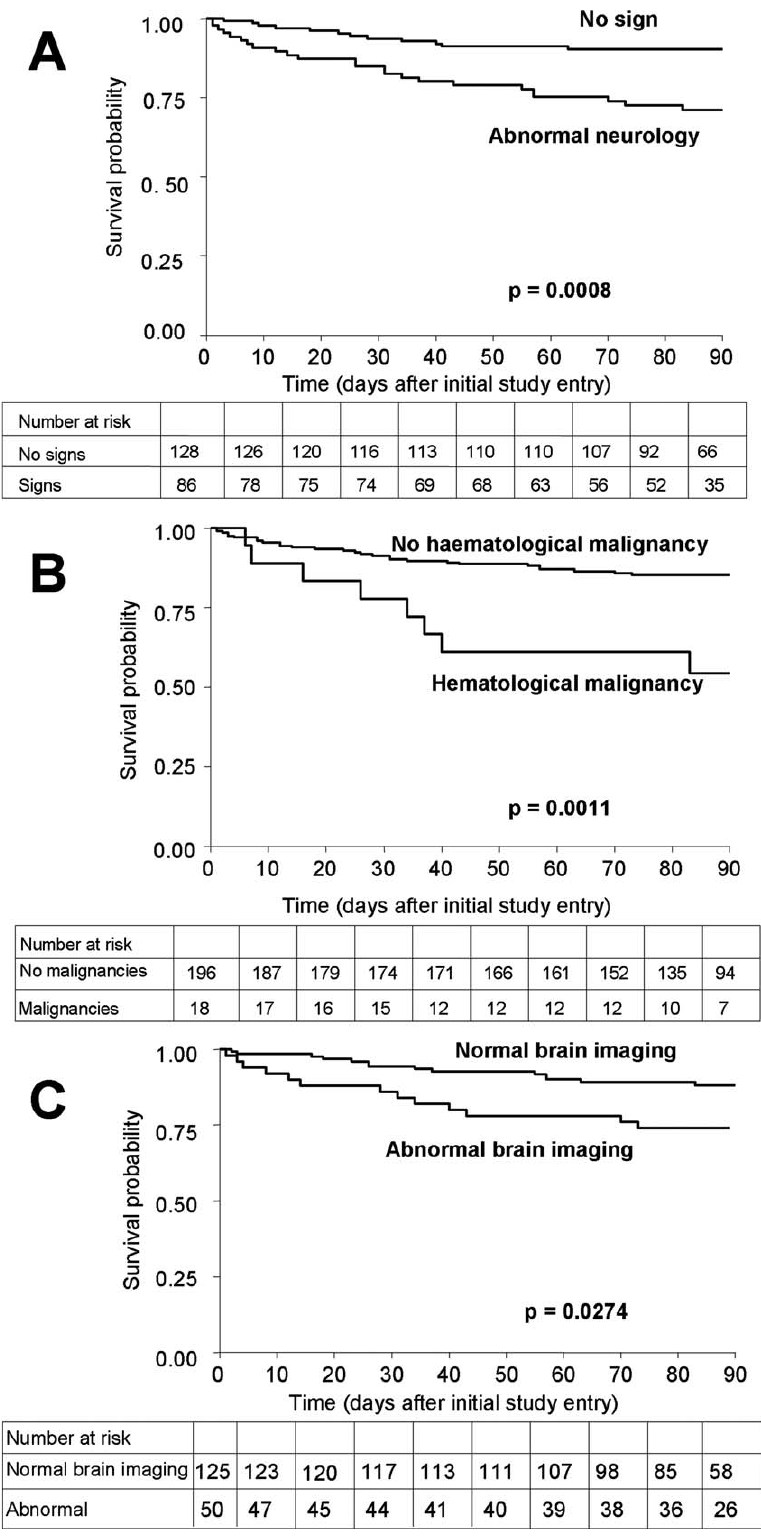
Figure 2. Overall Survival at Three Months after the Diagnosis of Cryptococcosis (A) Patients presenting with and without abnormal neurology at baseline. (B) Patients with and without haematological malignancies. (C) Patients presenting with and without abnormal brain imaging at baseline (data missing for 39 patients).